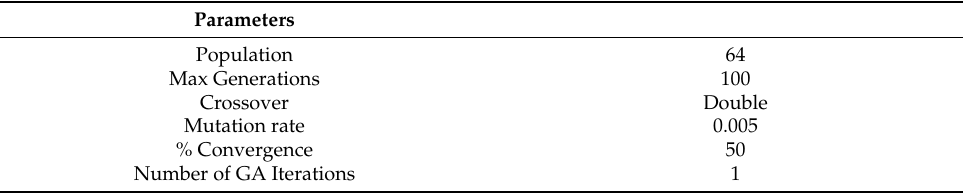
Table 1. Genetic algorithm